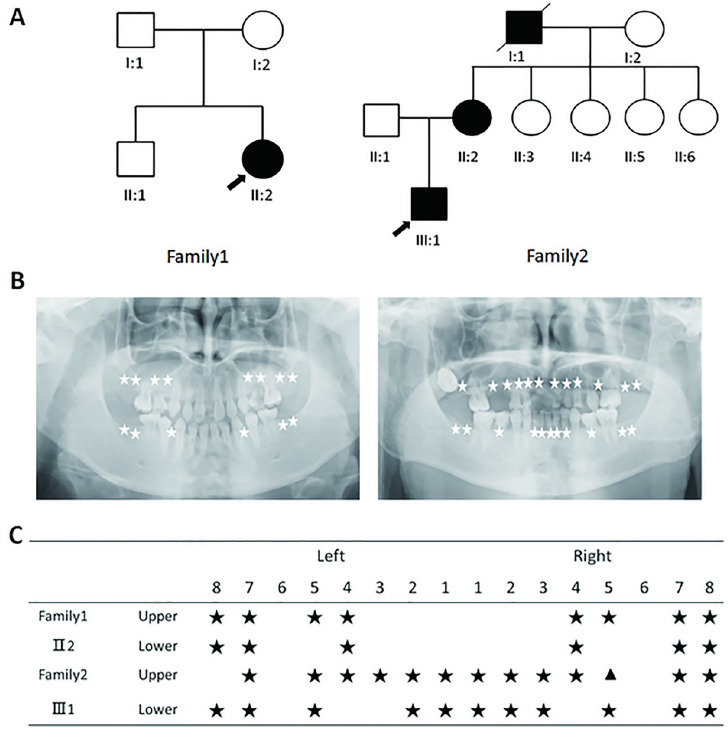
Fig 1. Identification of two Chinese families with non-syndromic tooth agenesis. (A) Pedigrees. Filled and unfilled symbols indicate affected and unaffected individuals, respectively. Squares and circles represent males and females, respectively. (B) Panoramic radiograph of the probands. The white stars indicate missing permanent teeth. Left: The proband of family I. Right: The proband of family II. (C) Tooth phenotypes of the probands with oligodontia. Stars indicate congenital missing tooth and triangle denotes cone-shaped